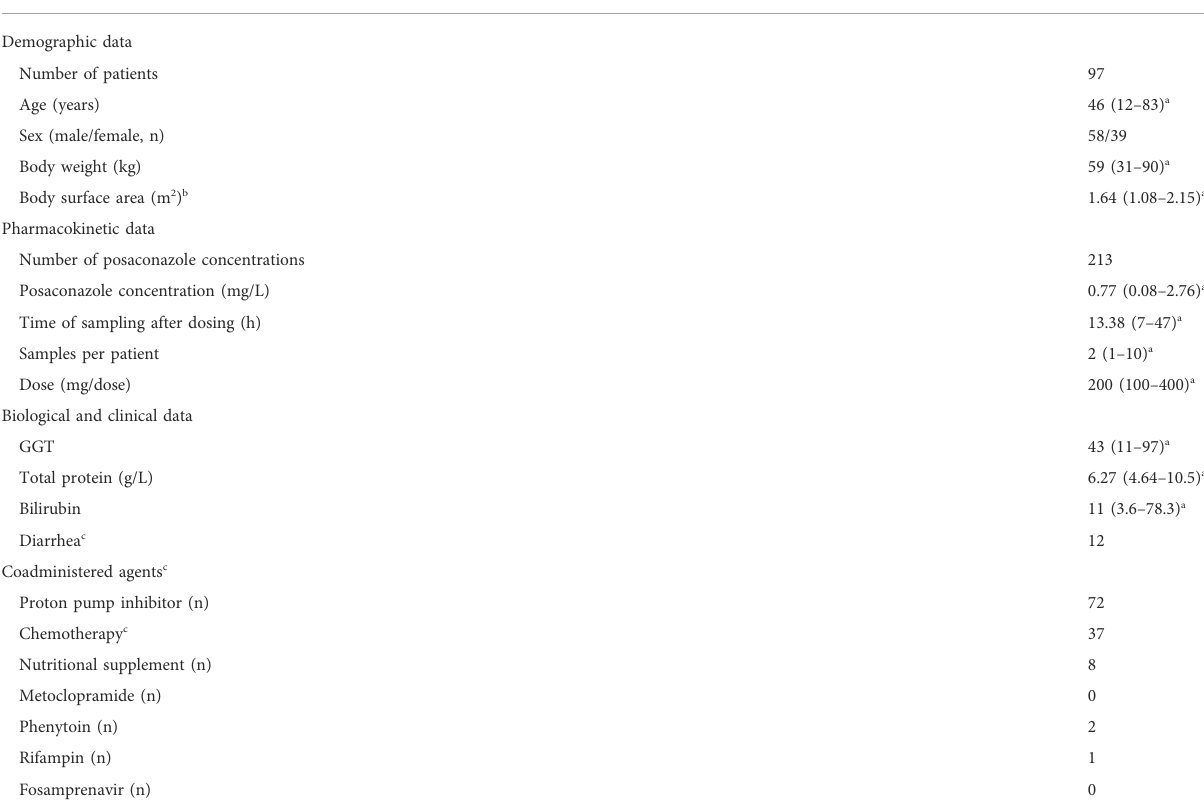
TABLE 2 Summary of the demographic information and clinical data of the external data set.